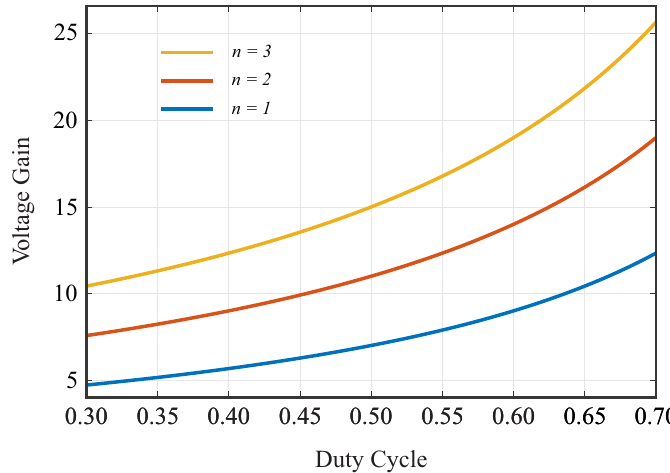
Figure 4. Duty cycle versus voltage gain curves under different